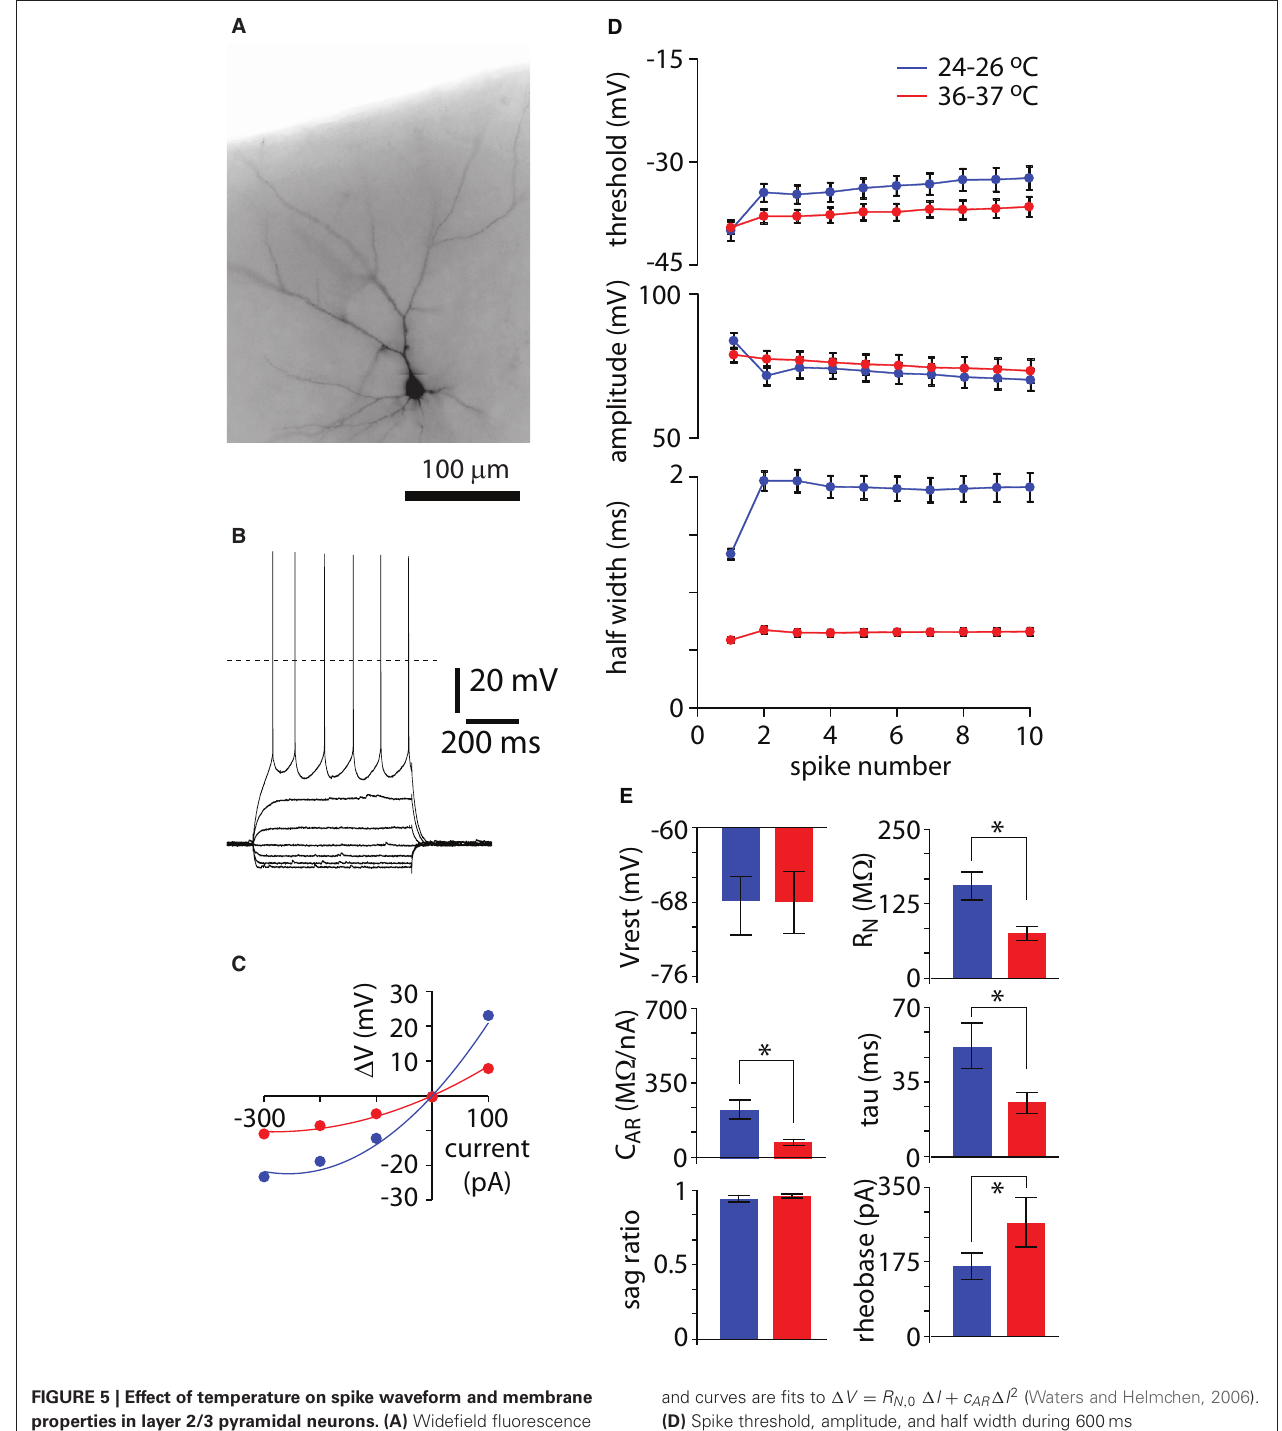
FIGURE 5 | Effect of temperature on spike waveform and membrane properties in layer 2/3 pyramidal neurons. (A) Widefield fluorescence image of a layer 2/3 pyramidal neuron, filled with Alexa 594 via the recording pipette. Note that the apical dendritic tree is intact. (B) Voltage responses to somatic current injection in the neuron in panel A . 100pA current steps from − 300 to + 300pA at 35 ◦ C. (C) V-I curves at 25 (blue) and 36 ◦ C (red) for the neuron in panel A , generated from results such as that in panel B . Points denote steady-state voltage measurements